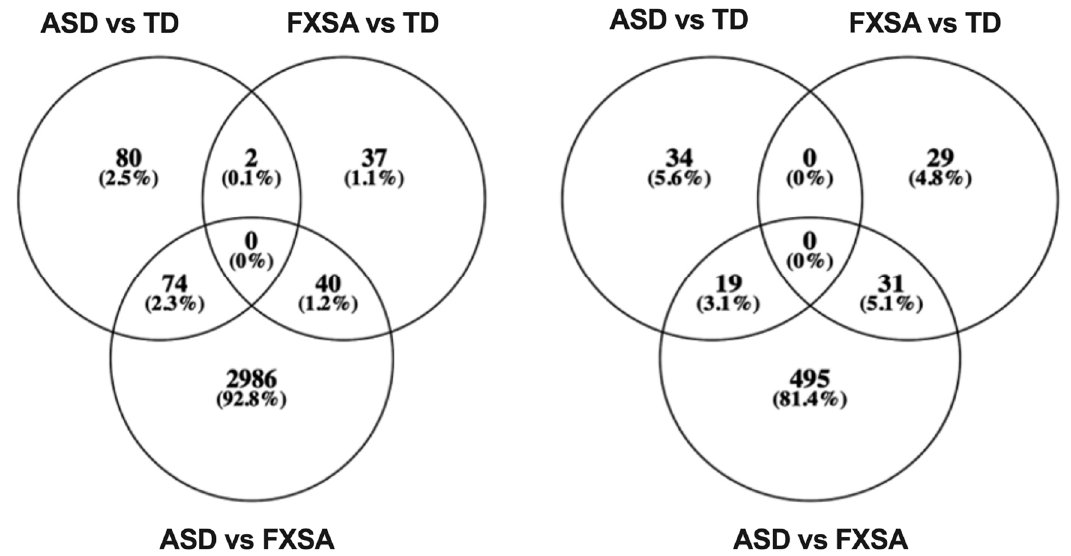
Figure 2. Venn diagram comparison of DMS among the different disease groups. The left Venn diagram shows the DMS, which were identified by FDR ≤ 0.05. On the right, the Venn diagram shows the DMS, identified by FDR ≤ 0.05 and absolute difference of beta value ≥ 0.05.